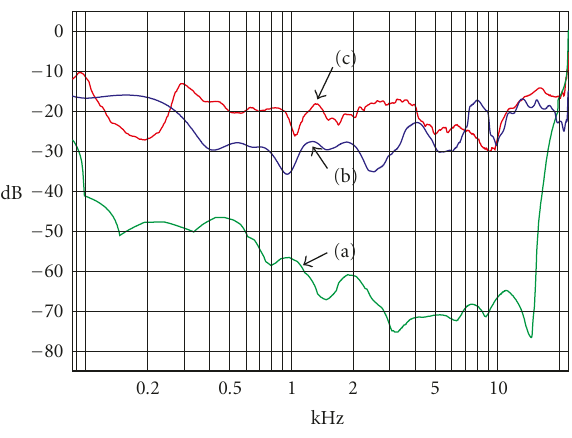
Figure 8: The CAVE-like environment at RWTH Aachen Univer- sity. Four loudspeakers are mounted on the top rack of the system. The door, shown on the left, and a moveable wall, shown on the right, can be closed to allow a 360-degree view with no roof projec- tion.